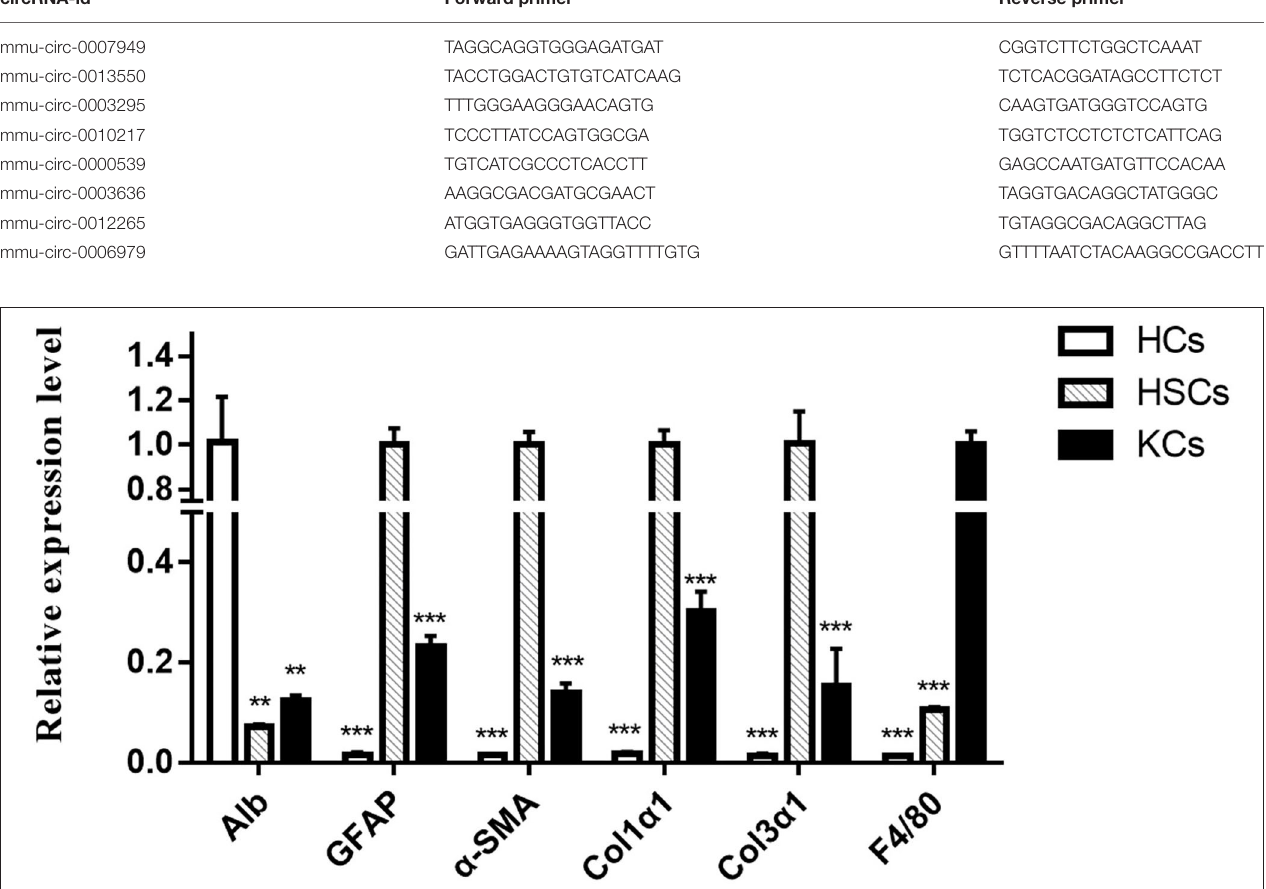
FIGURE 1 | The relative expression levels of different cell markers in hepatocytes, hepatic stellate cells, and Kupffer cells were determined by qRT-PCR. The number of biological replicates for each experiment was 3, and the relative expression levels were normalized to the expression levels of GAPDH. Data are presented as means with SD. P -values were analyzed by Student’s t -test. *** P < 0.001 and ** P <